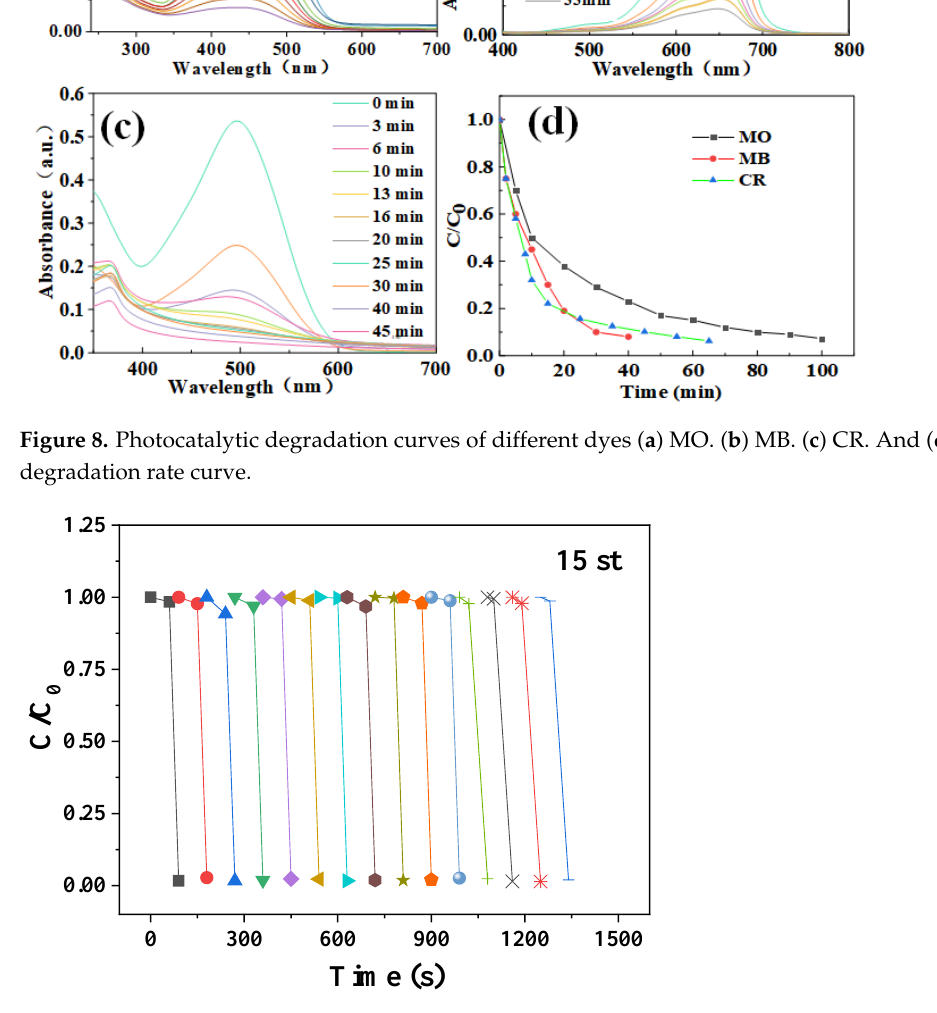
Figure 9. Cycles performances of CR. Table 2. Degradation efficiency of dyes by